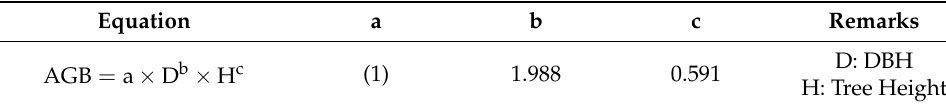
Table 1. Single tree AGB equations of Chinese fir.